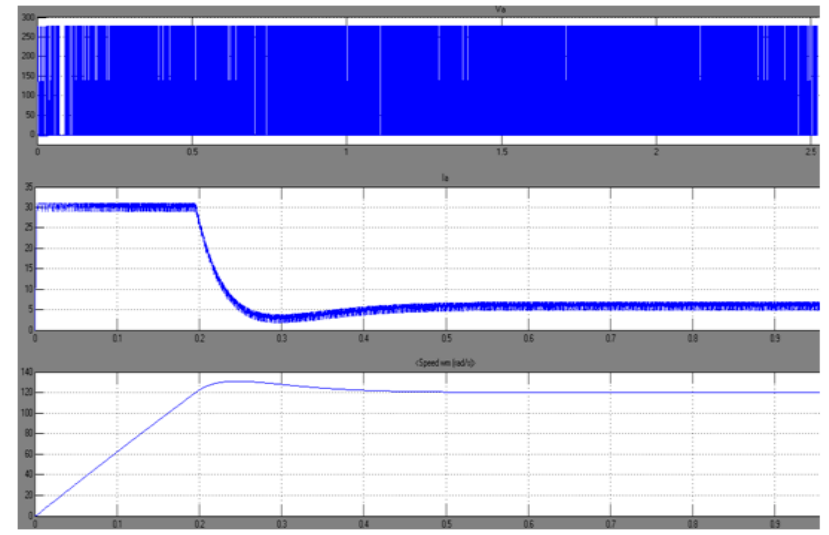
Figure 13. Simulation results of PID controller.